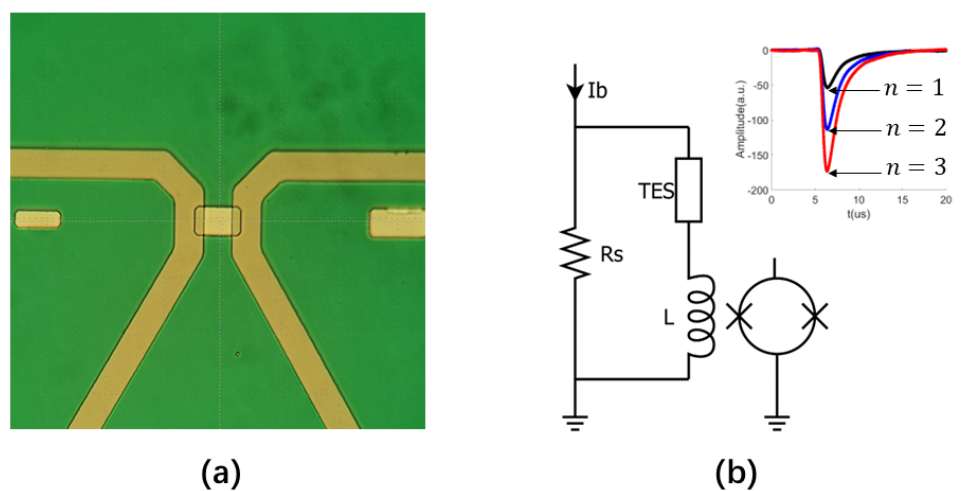
Figure 8. Photon counting experiments based on Titanium/Silver TES aligned by reflected wave intensity measurement. ( a ) Micrograph of a fabricated TES device. ( b ) A voltage-biased TES cir- cuit, realized using a current source I b and a shunt resistance Rs that is much smaller than the TES resistance. The current change in the TES due to absorbed photons is measured by an induc- tively coupled SQUID. Shown in the inset are the averaged response curves for different absorbed photon